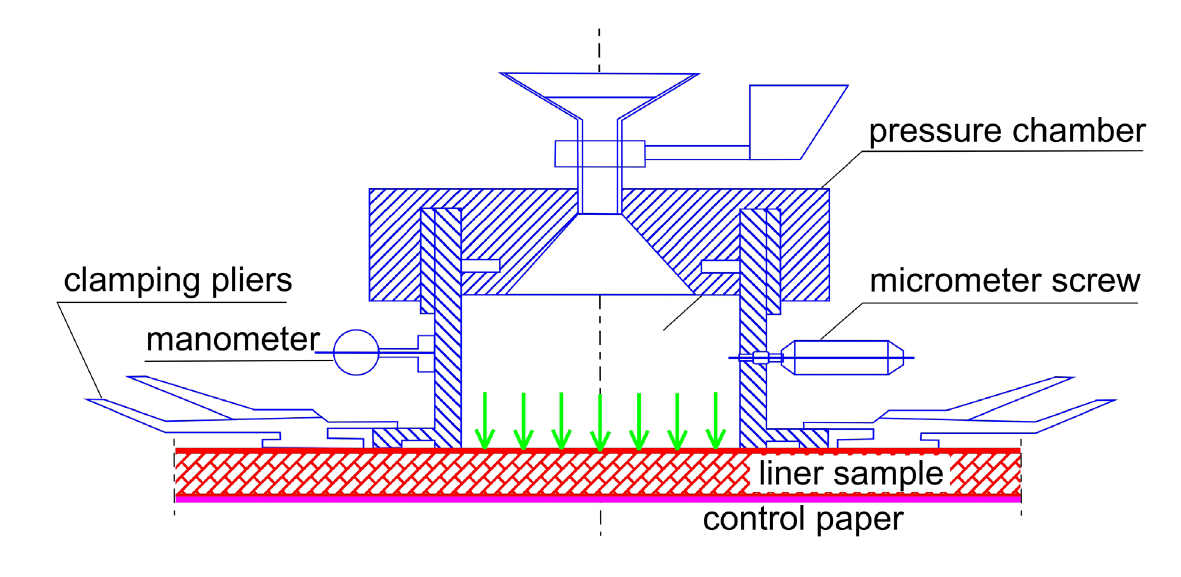
Figure 4: Illustration of the GWT method for measuring water permeability